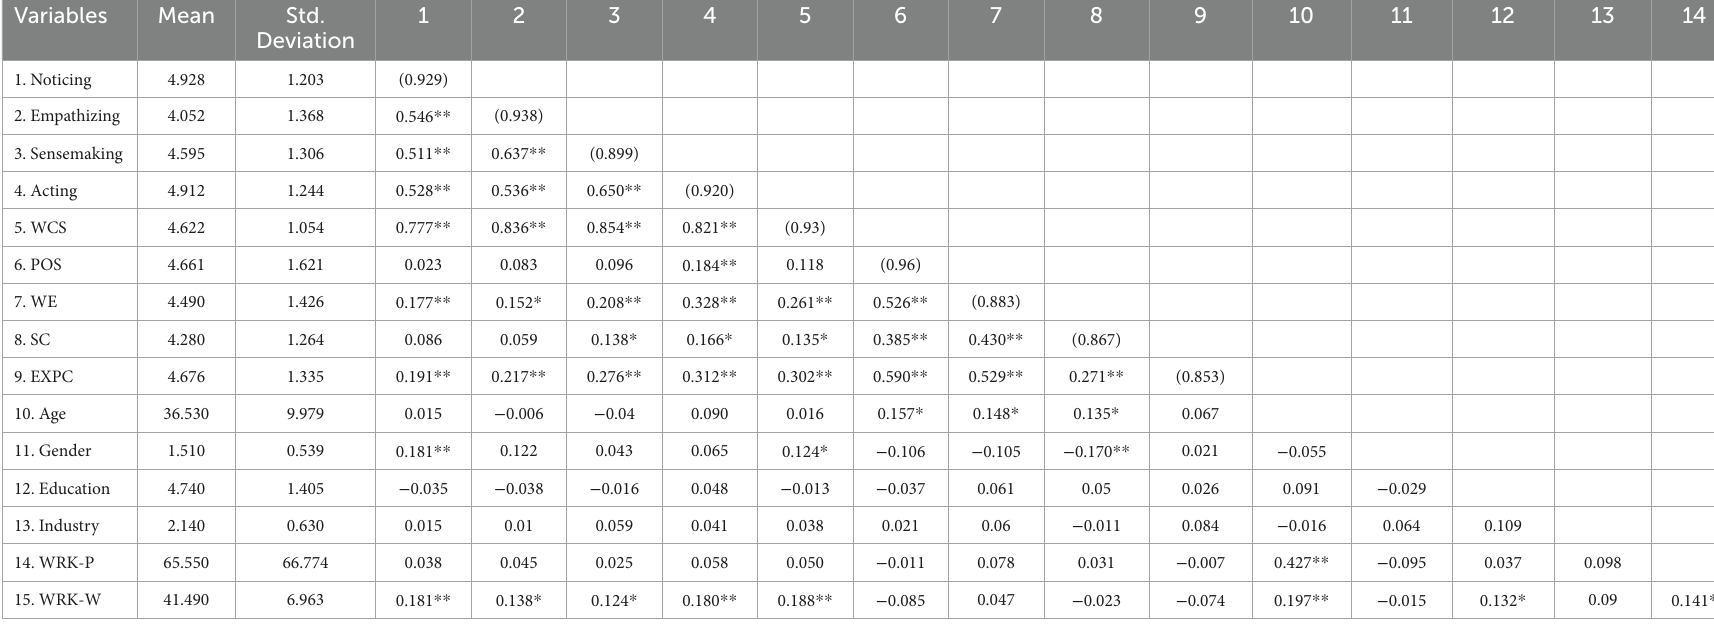
TABLE 6 Means, standard deviations, correlations, and reliabilities for nomological validity ( N = 255).